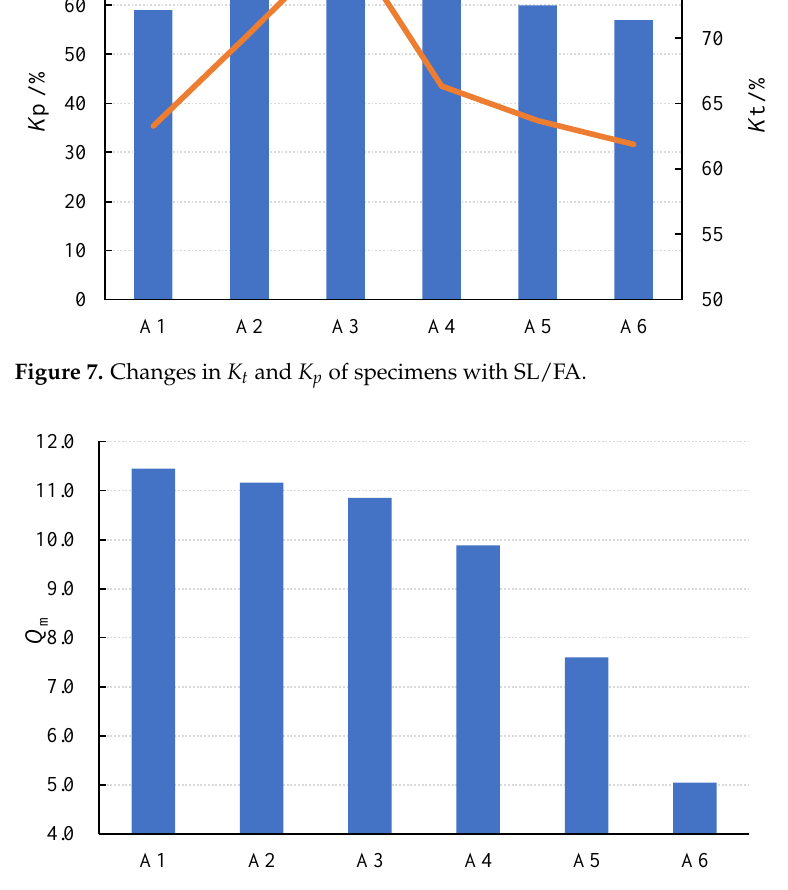
Table 7. Changes in Z of specimens with SL/FA.